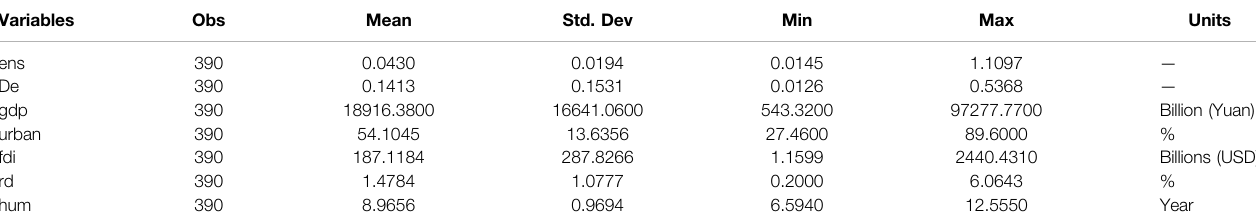
TABLE 2 | Description of sample statistics.